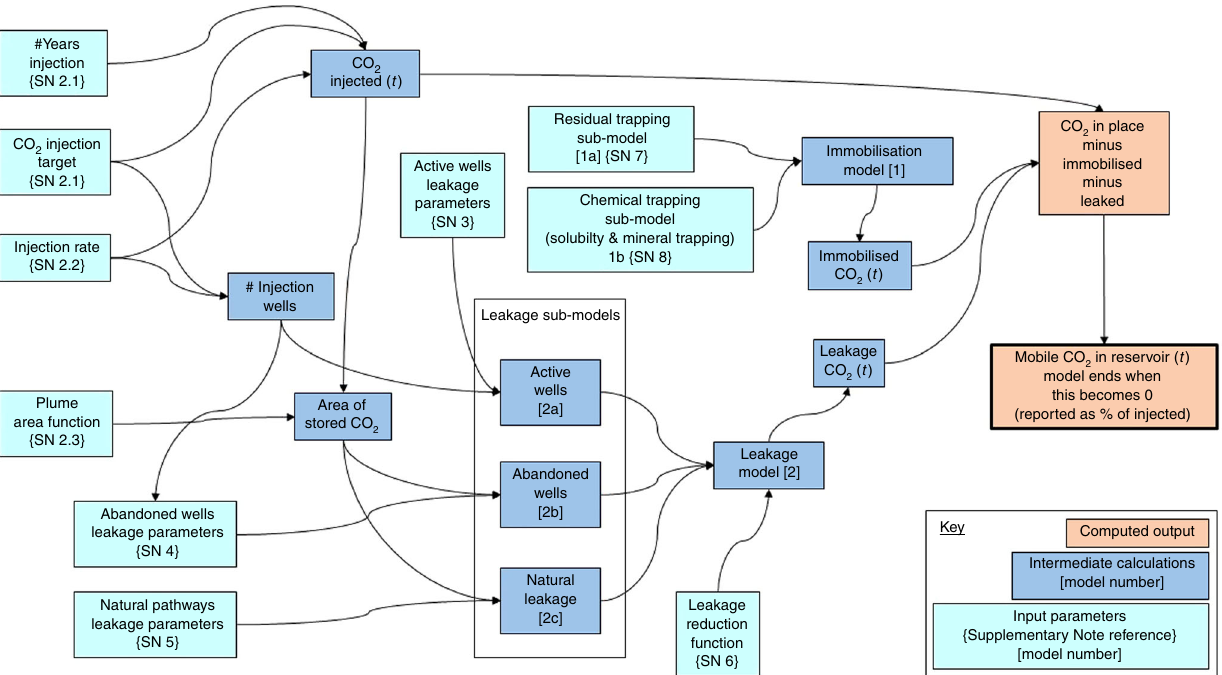
Fig. 6 Schematic fl ow diagram of the Storage Security Calculator program. The program relies on 26 input parameters, each are called in at least one of the models. These parameters are listed in Table 3, along with the values applied. Discussion of how the values were derived is provided in the